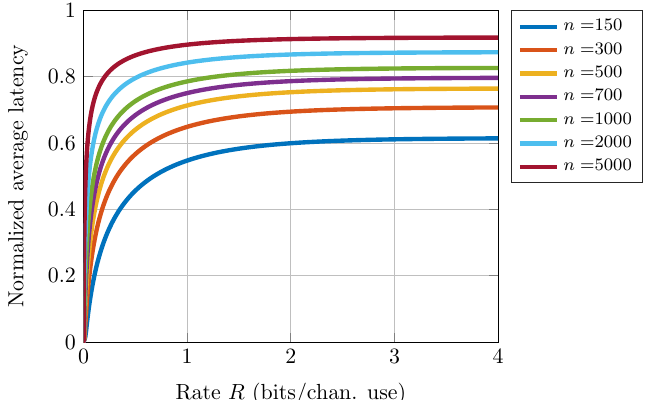
Fig. 4 Normalized average latency as a function of channel code rate for various blocklength n and a block error rate (BLER) ǫ = 10 −